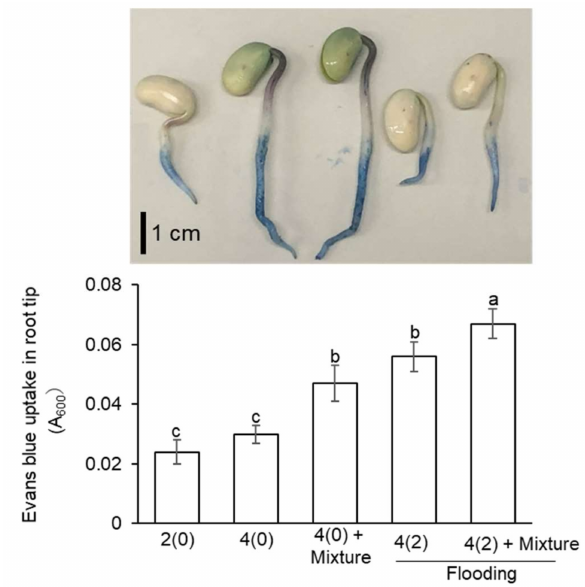
Figure 3. Evaluation of cell death in soybean roots treated with silver NPs / nicotinic acid / KNO 3 under flooding stress. Two-day-old soybeans were flooded with or without 5 ppm silver NPs / 8 µ M nicotinic acid / 0.1 mM KNO 3 . After the treatments, soybean plants were stained with 0.25% Evans blue dye. The Evans blue dye was then extracted from the root tip and absorbance was measured at 600 nm. Data are presented as the mean ± S.D. from three independent biological replicates. Mean values of each data point with di ff erent letters are significantly di ff erent according to one-way ANOVA Duncan’s Multiple Range test ( p < 0.05). Scale bar indicates 1